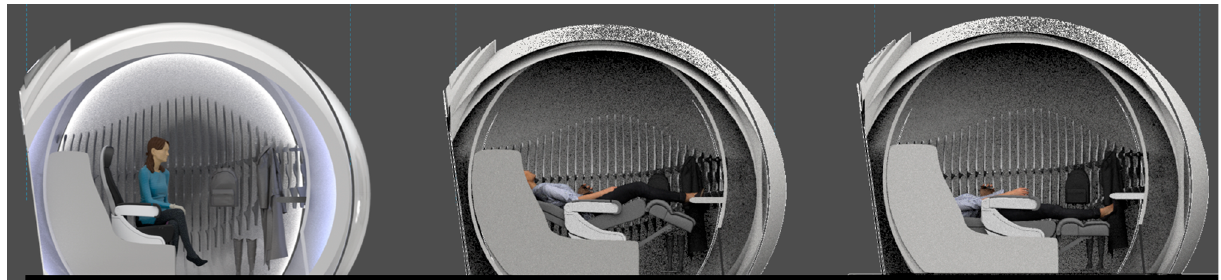
Figure 2. Elevation and sections illustrating the different seat positions: Seated Upright Position, Zero Gravity Position, and Napping Position in the “Reviving Pod” (design by the authors).